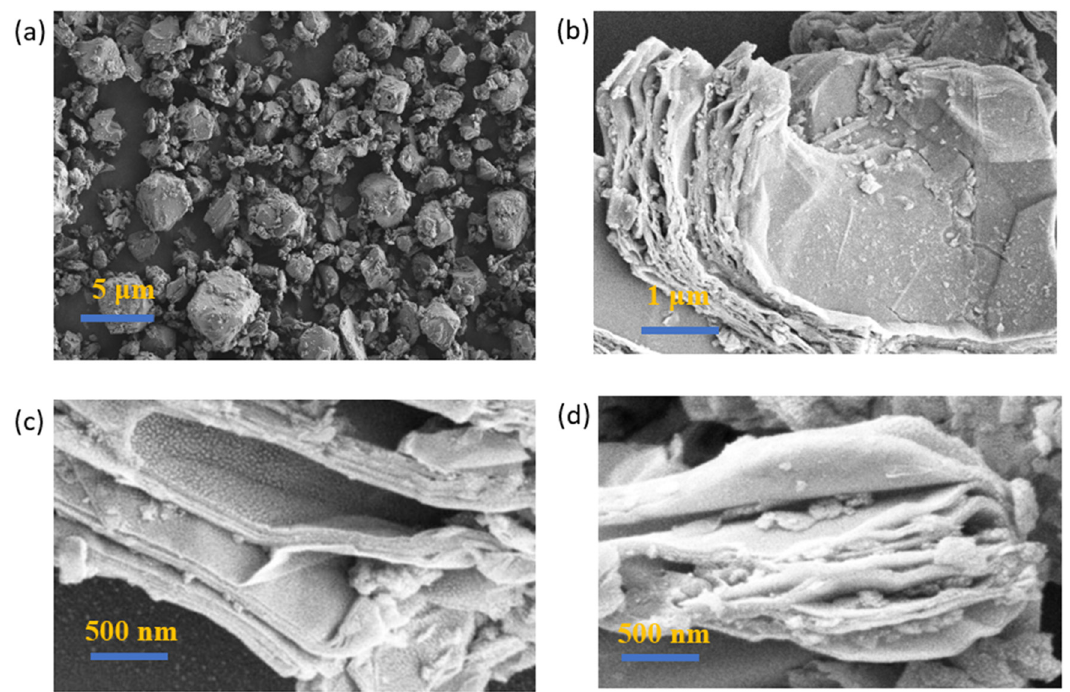
Figure 2: ( a ) SEM image of MAX ( Ti 3 AlC 2 ) ; ( b – d ) SEM images of Mxene ( Ti 3 C 2 T x )